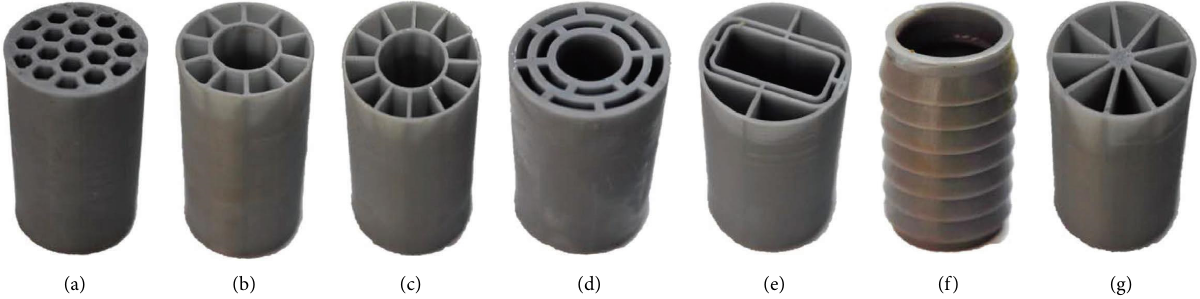
Figure 4: Te pictorial representation of nature inspired infll structures fabricated models: (a) TIHIs, (b) HIIs-10, (c) HIIs-12, (d) BIIs, (e) CIIs, (f) PIIs, and (g) NLIIs.